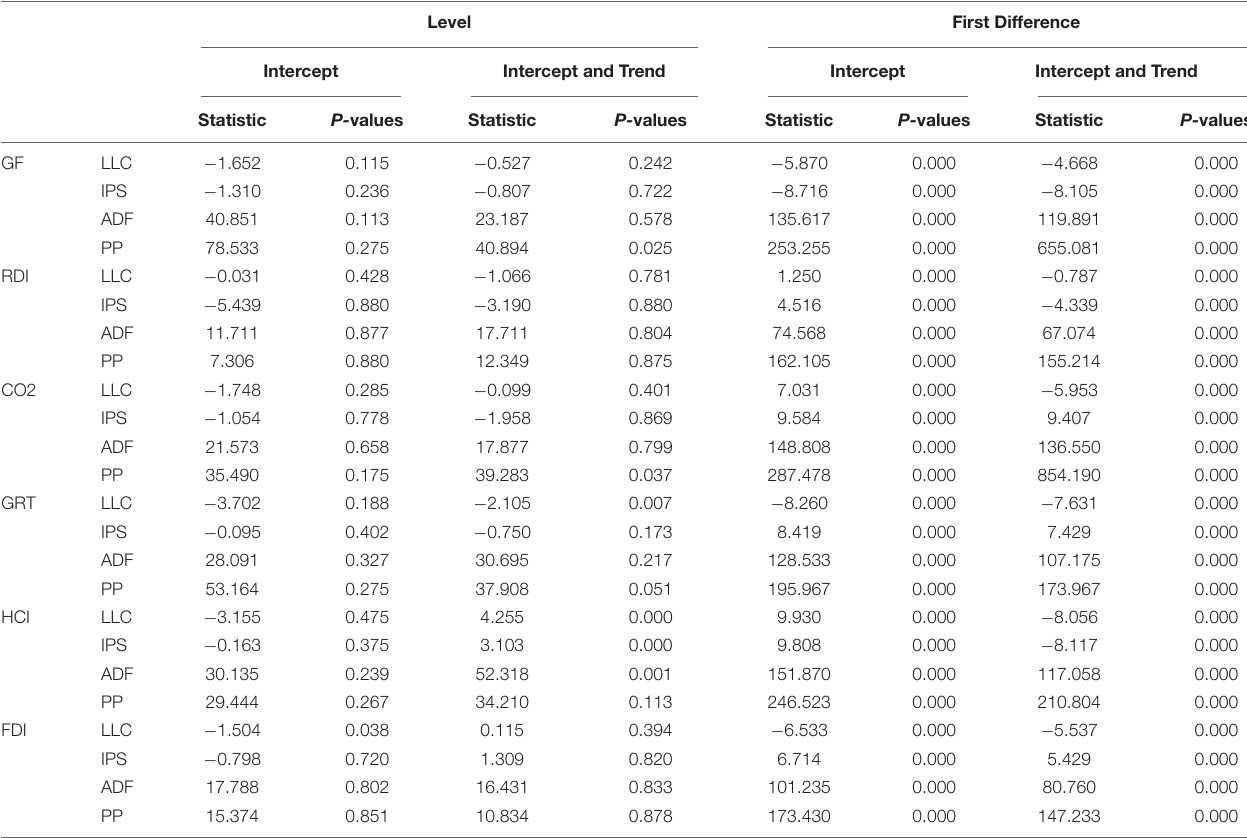
TABLE 4 | Unit root